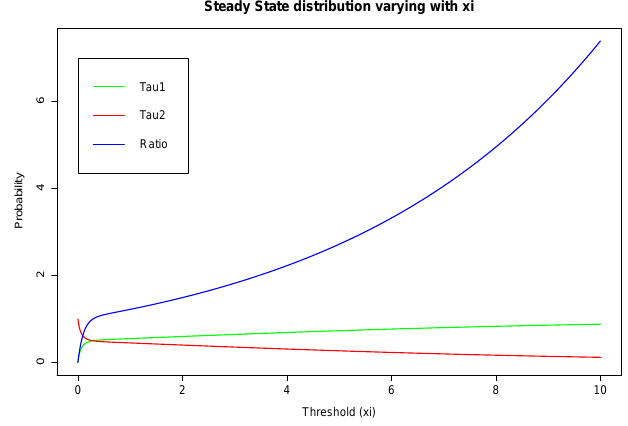
Figure 3. Steady state distribution when λ 1 = 0.2, λ 2 =